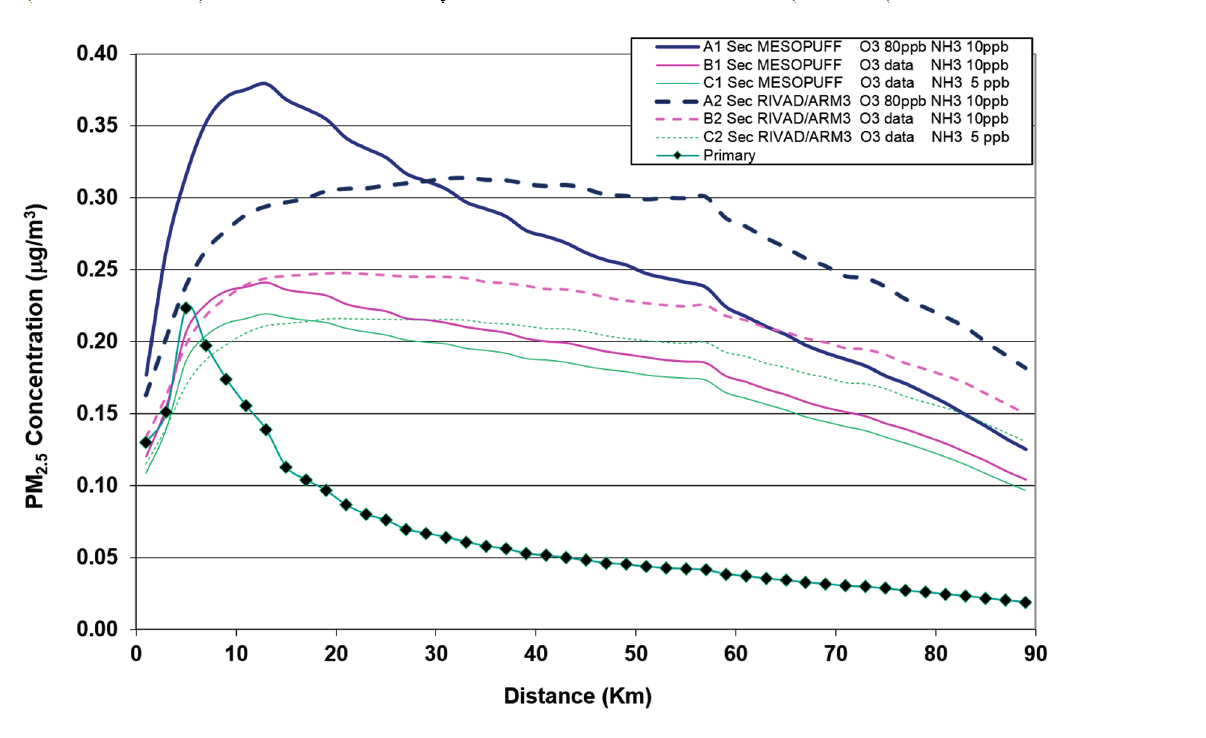
Figure 4. Estimated maximum annual average PM 2.5 concentrations (µg/m 3 ) plotted against distance from the source for different Calpuff